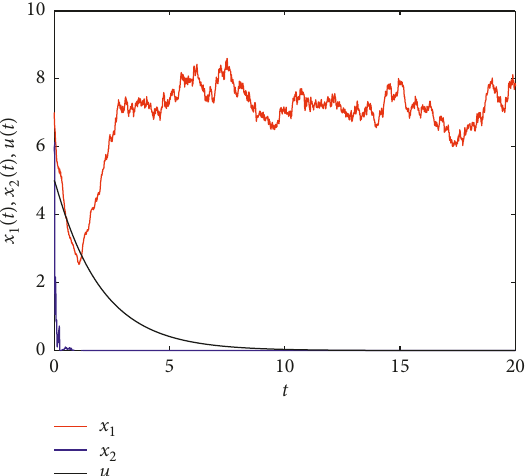
Figure 3: Time series diagram of ( x